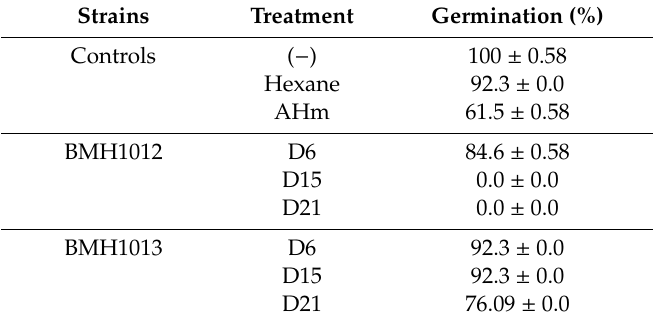
Table 3. E ff ect in germination of cucumber seeds of the supernatants of the media with AH´s mixture treated with BMH1012 and BMH1013